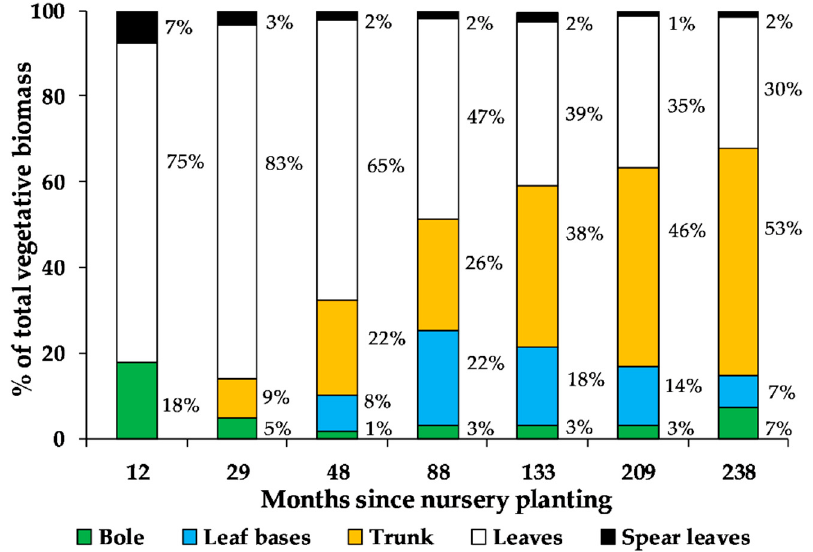
Figure 2. Proportion of vegetative biomass of different ages of tenera oil palm.